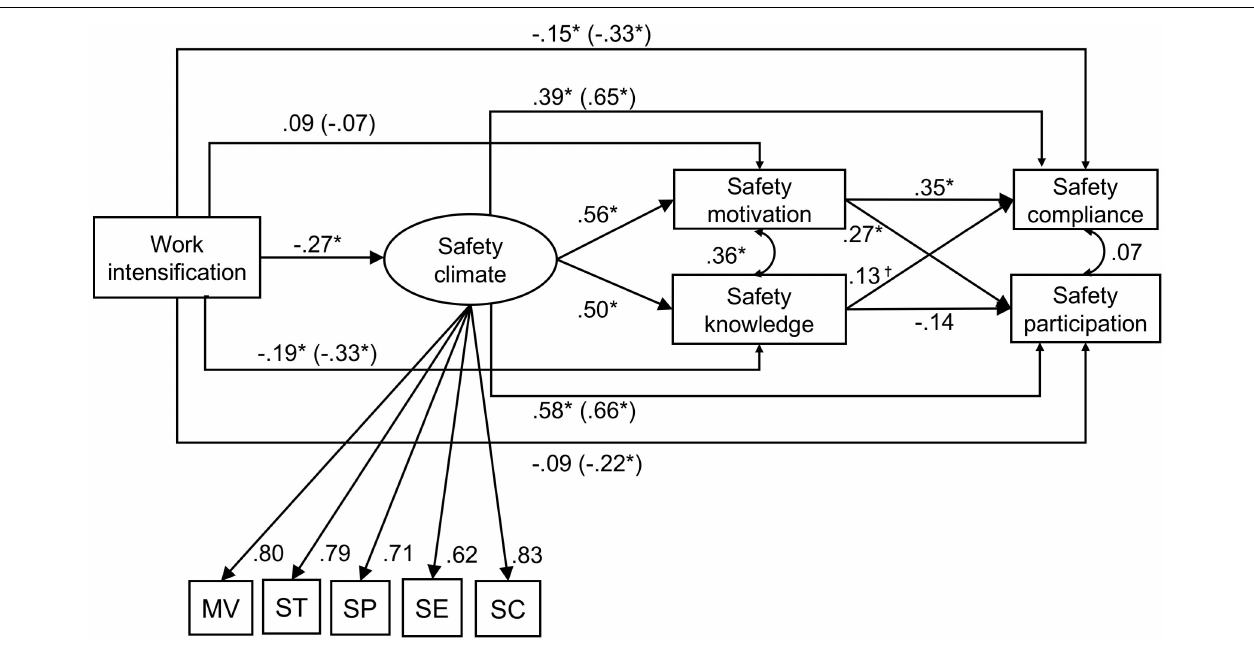
FIGURE 2 | Standardized estimates and total effects from structural equation modeling (SEM). † p < 0.10; ∗ p < 0.05. Total effects are displayed in parentheses. For visual clarity control variables are omitted. MVs, management values; ST, safety training; SPs, safety practices; SE, safety equipment; SC, safety communication.